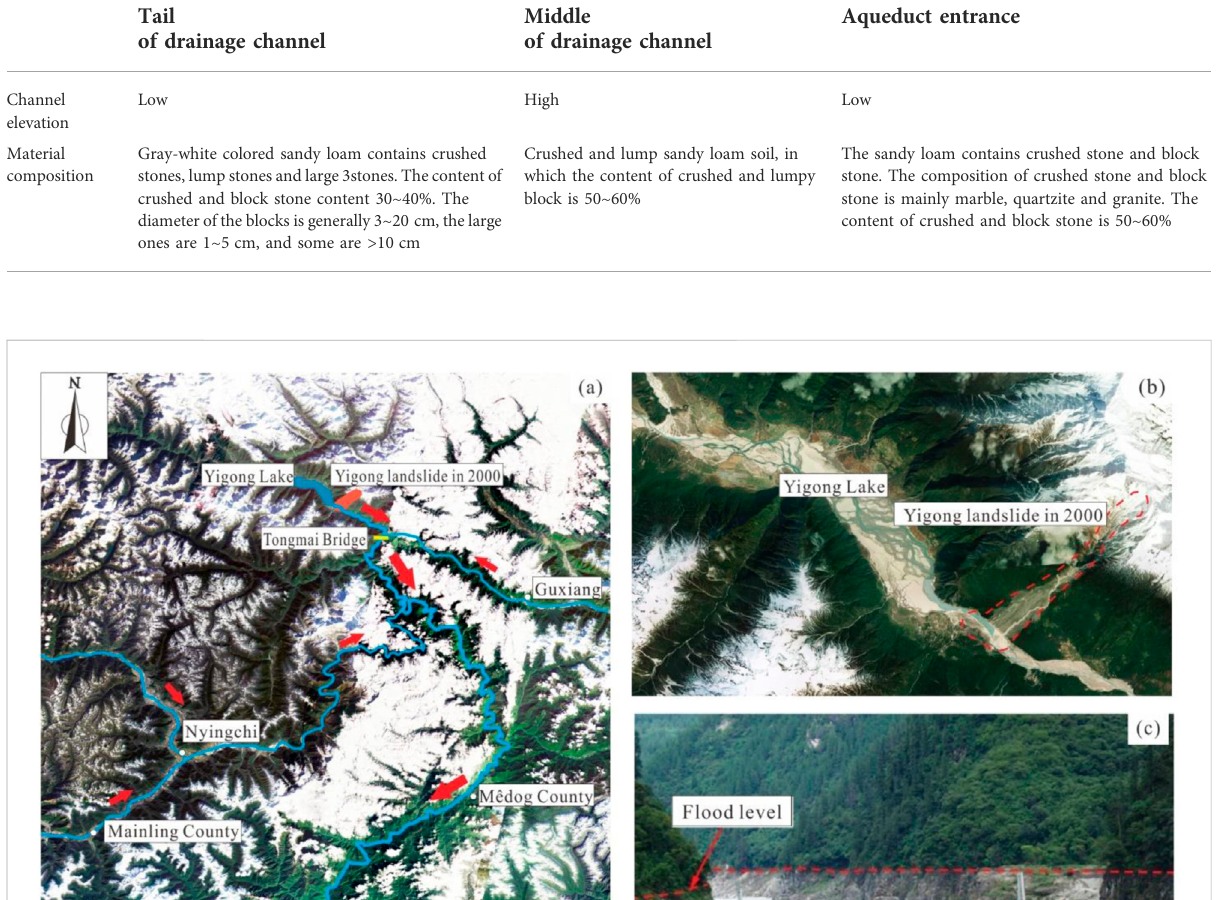
TABLE 6 Material composition table of the Yigong landslide dam body in